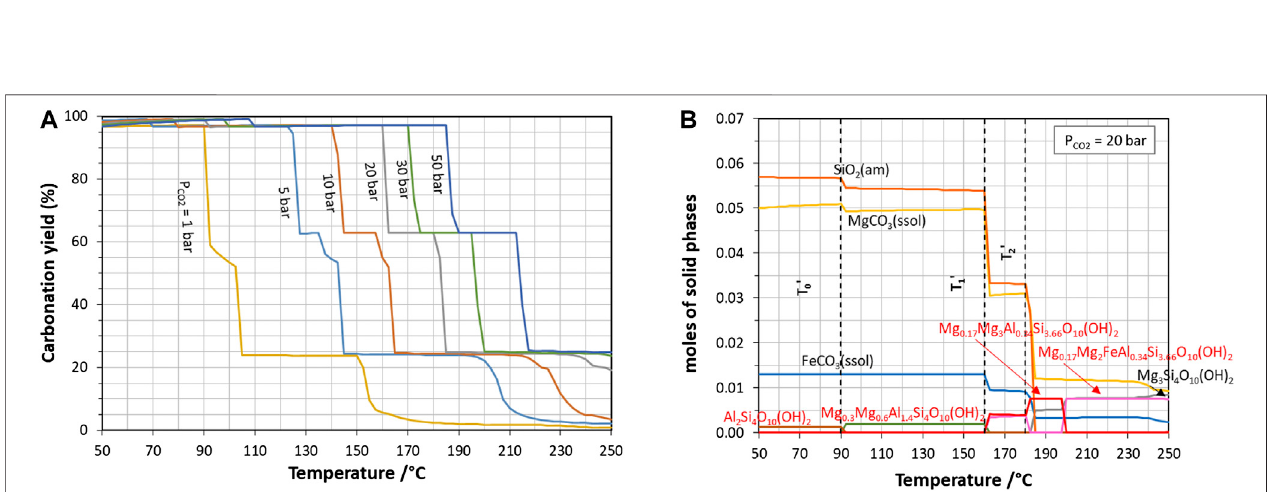
FIGURE 7 | Effect of temperature on the carbonation of slag described as system 2 (major and minor metal oxides): (A) carbonation yield at different CO 2 partial pressures and (B) solid carbonation products at 20 bar of CO 2 (only precipitated phases containing Si, Mg and/or Fe are shown here).